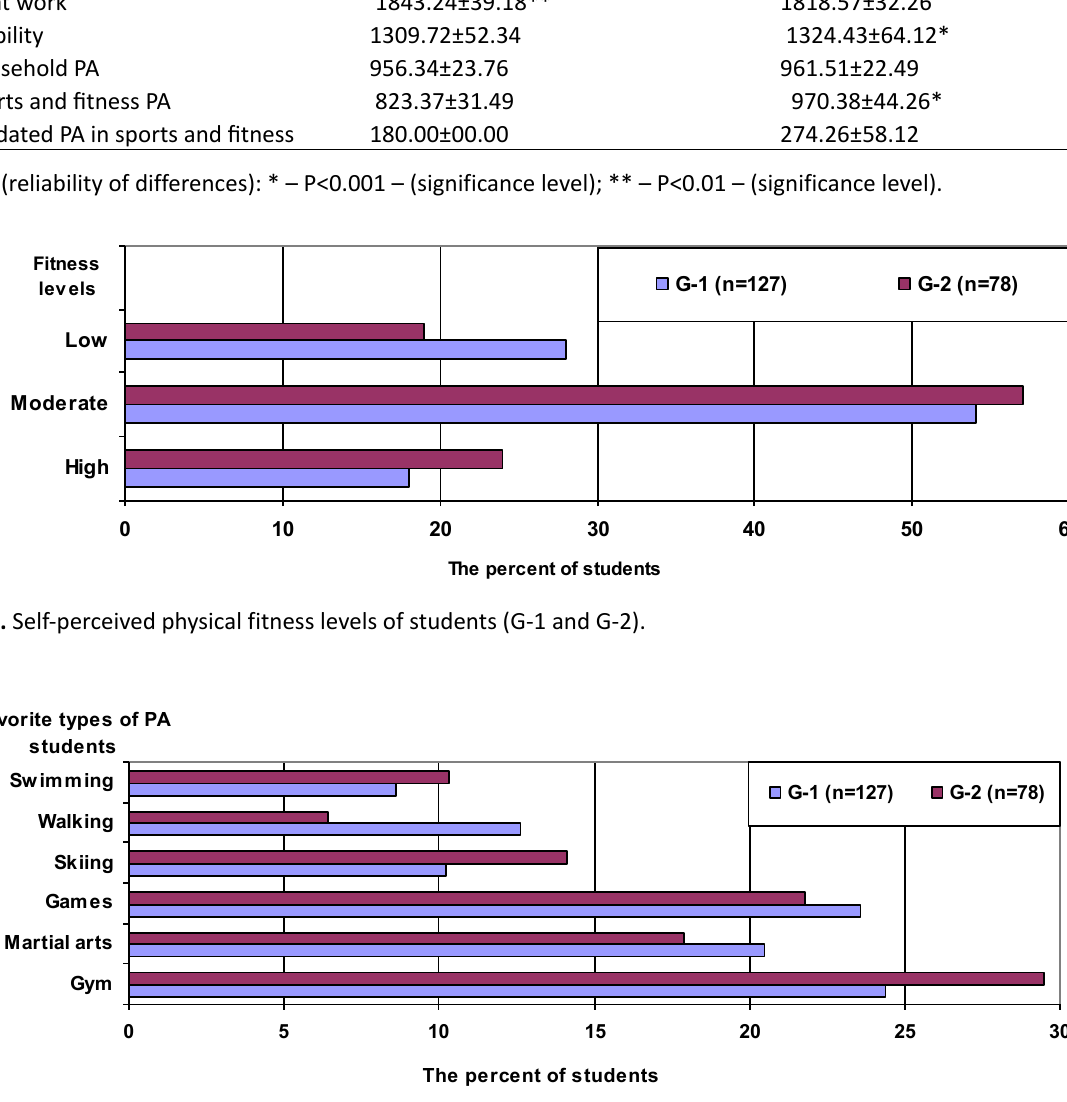
Fig. 2. Favorite types of weekly PA of students (G-1 and